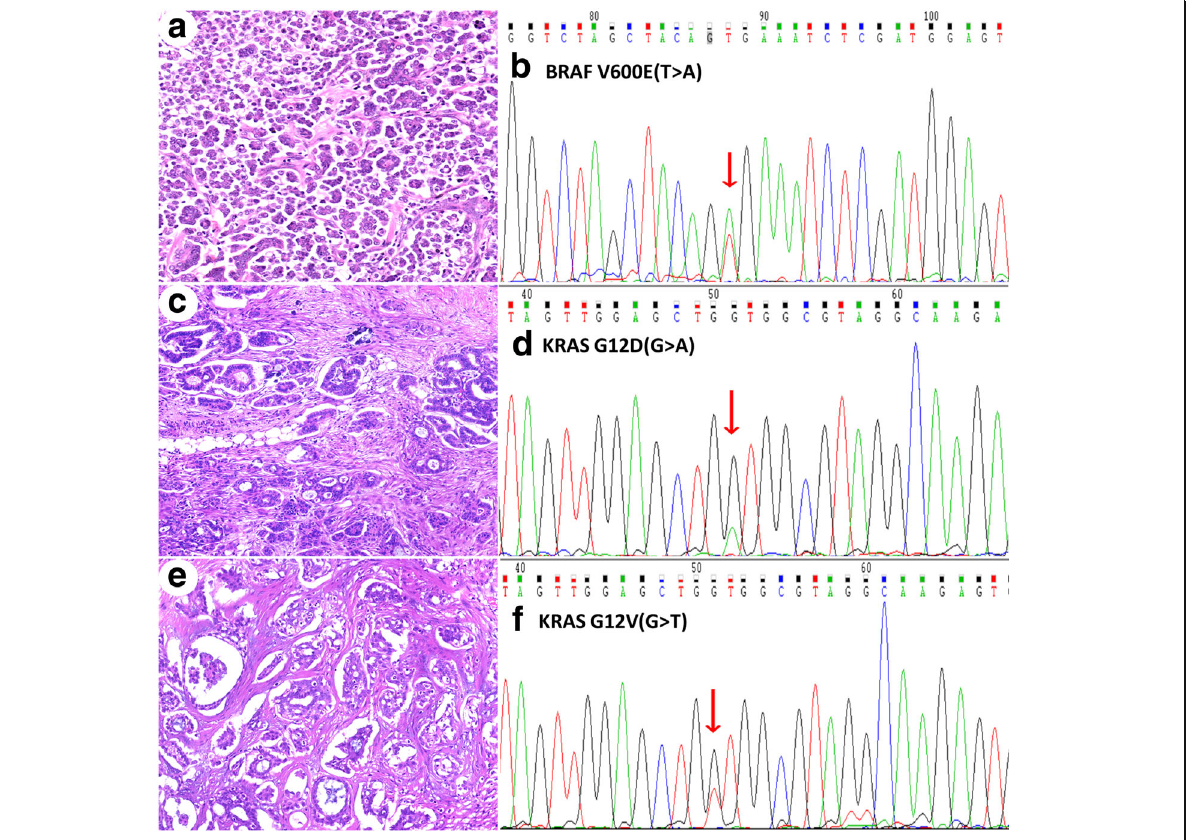
Fig. 1 Histology and nucleotide sequences of KRAS or BRAF in 3 representative LGSC cases. Case 1: a , H&E staining of the tumor. b , Chromatogram of the nucleotide sequence shows a point BRAF V600E mutation (GTG to GAG) in LGSC. Case 2: c , H&E staining of the tumor. d , Chromatogram of the nucleotide sequence shows a point KRAS G12D mutation (GGT to GAT) in LGSC. Case 3: e , H&E staining of the tumor. f , Chromatogram of the nucleotide sequence shows a point KRAS G12 V mutation (GGT to GTT) in LGSC. H&E slides, magnification